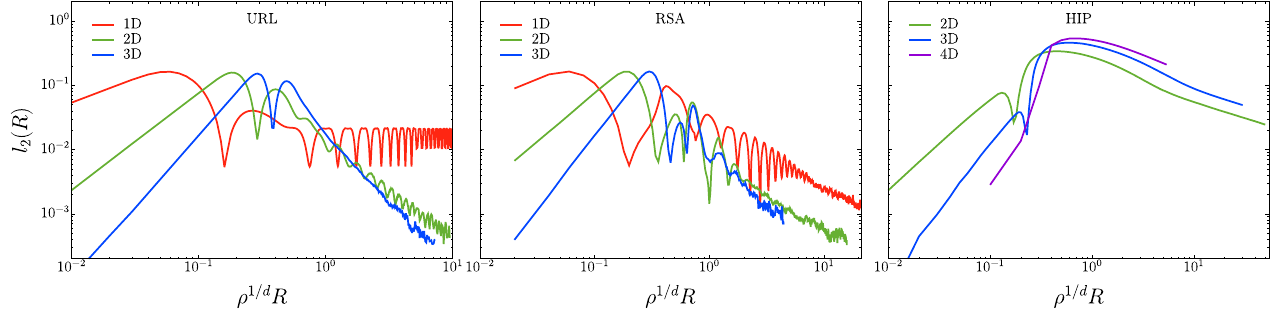
FIG. 7. Gaussian distance metric l 2 ð R Þ versus R for a representative disordered hyperuniform model (URL), a sub-Poisson nonhyperuniform model (RSA), and an antihyperuniform model (HIP) across the first three space dimensions,